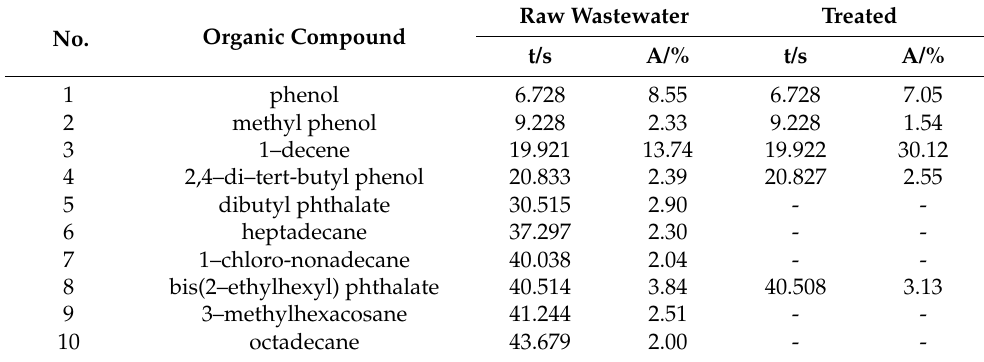
Table 1. GC–MS analysis results of coking wastewater before and after C18CTS–BT treatment.